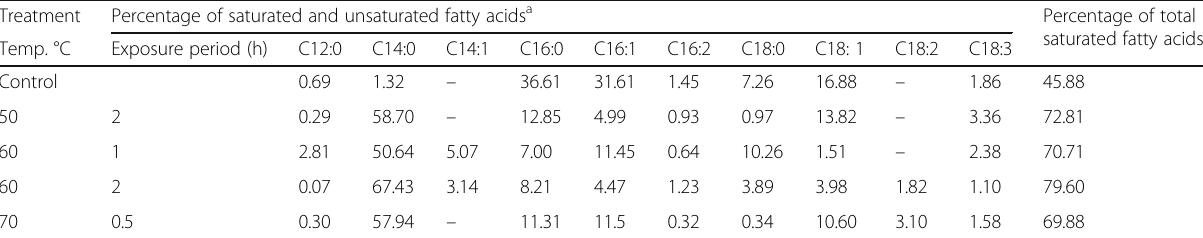
saturated fatty acids